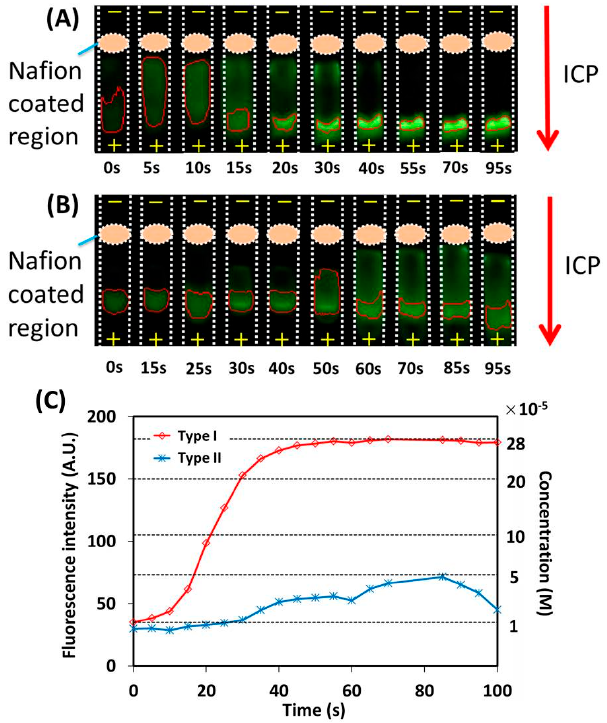
Figure 6. Experimental result with two types of ICP devices. ( A ) Fluorescence images captured at different times with ICP device type I; ( B ) Fluorescence images captured at different times with ICP device type II; ( C ) Variation of fluorescent signal intensity and corresponding sample concentration over time with two types of ICP devices.